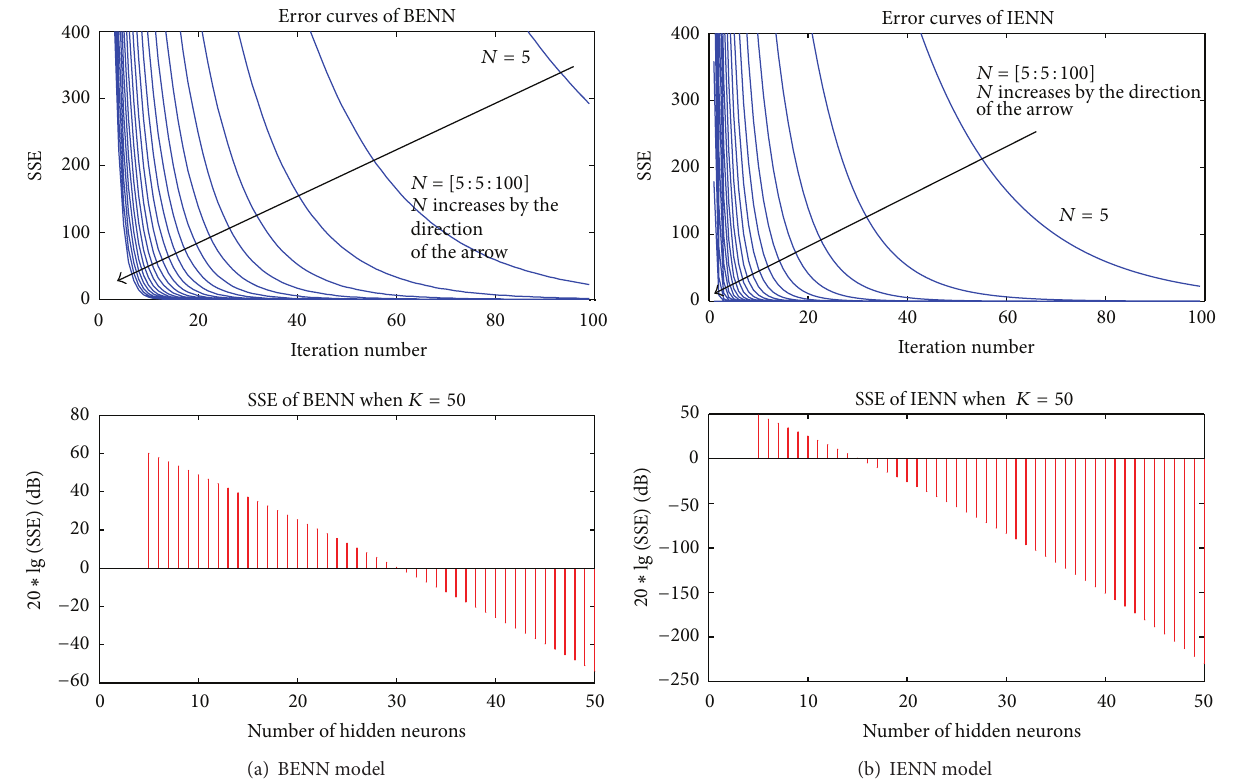
Figure 4: SSE varying with iteration number 𝐾 and number of hidden neurons 𝑁